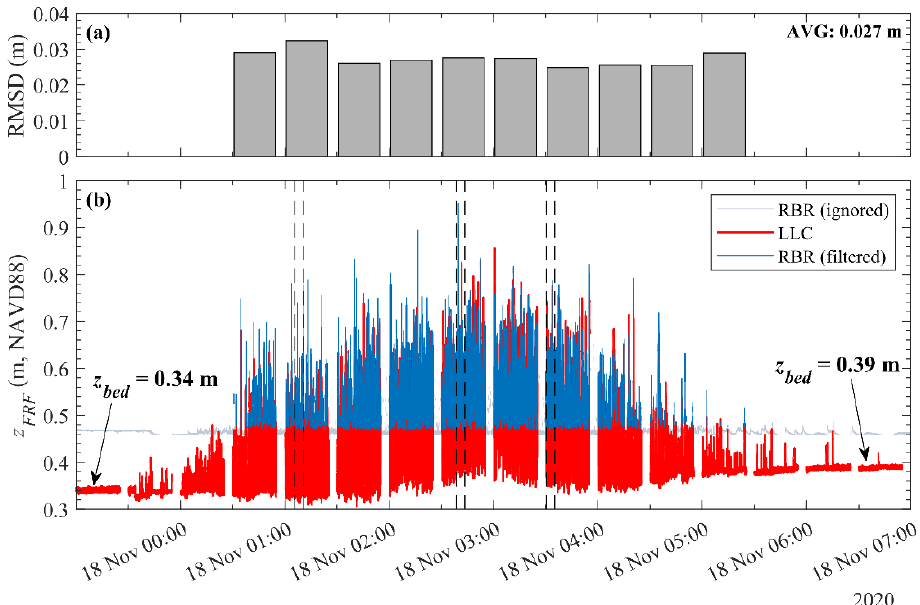
Figure 12. ( a ) Root-mean-square difference (RMSD) between RBR- and LLC LiDAR-derived free- surface elevation for each 25-min span. ( b ) Free-surface elevation during Series C (18 November 2020), high tide #3 (at x FRF = 83.88 m), measured by the RBR (blue) and LLC LiDAR (red). The light-blue curve indicates RBR data that were ignored for RMSD computation, due to water levels dropping below the RBR pressure transducer. The dashed black lines mark the time spans shown in Figure 13. Times in UTC.